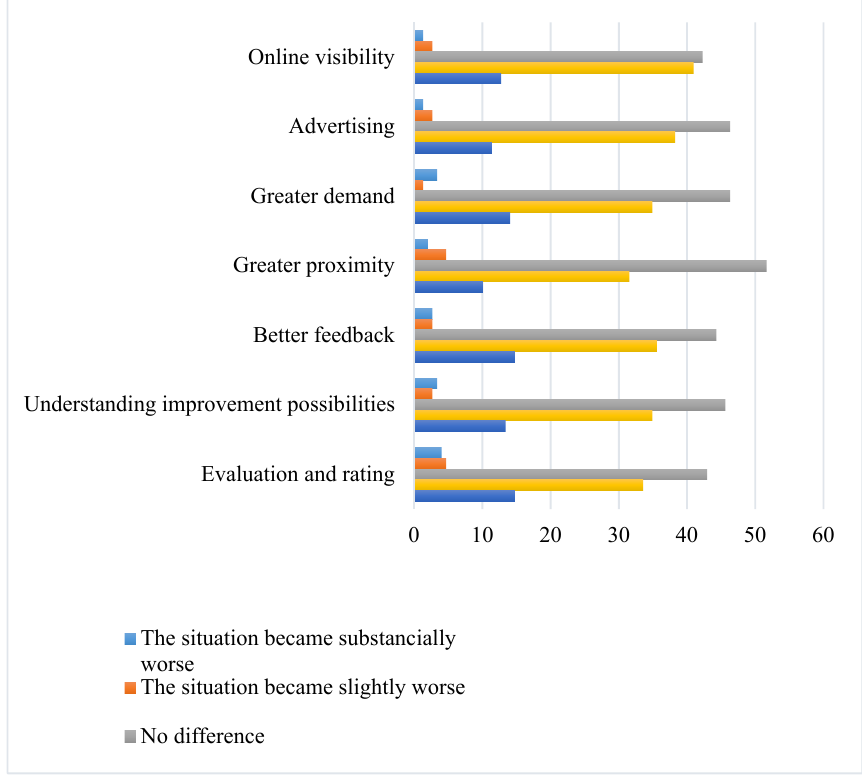
Figure 11. TripAdvisor’s advantages for restaurant businesses (%).